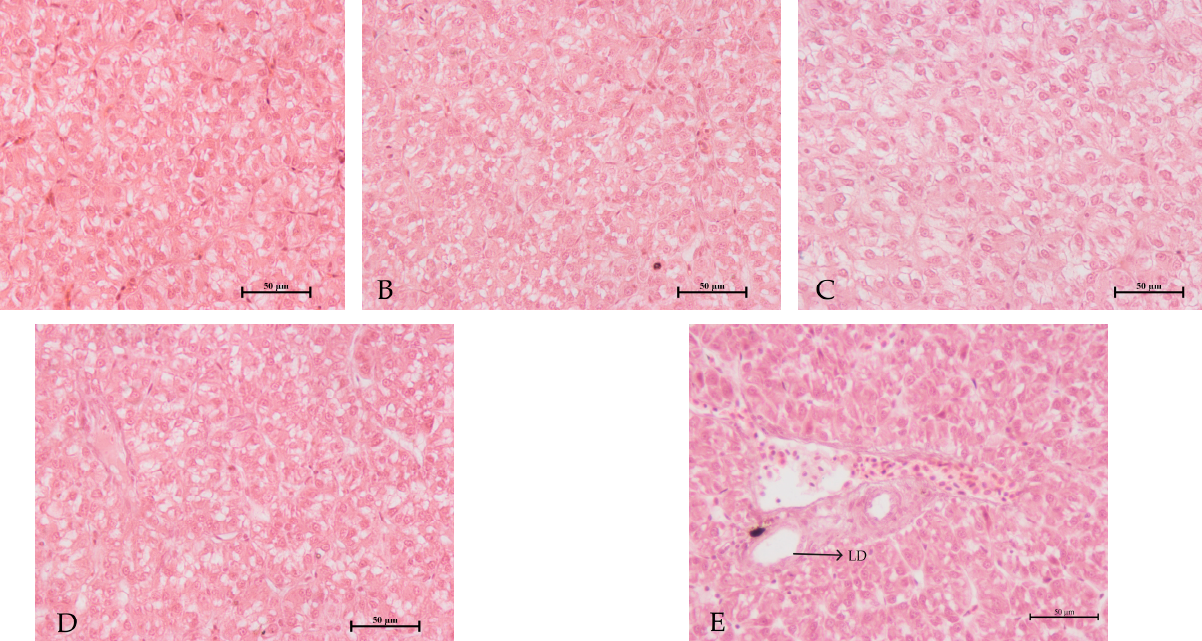
Figure 1. Effect of replacing fishmeal with cottonseed protein concentrate (CPC) and Clostridium autoethanogenum protein (CAP) mixture on foregut morphology of rainbow trout (10×). ( A ): CON; ( B ): FM-15; ( C ): FM-10; ( D ): FM-5; ( E ): FM-0; VH: villus height; VW: villus width; MT: muscle thickness. Scale bar = 200 µ m.